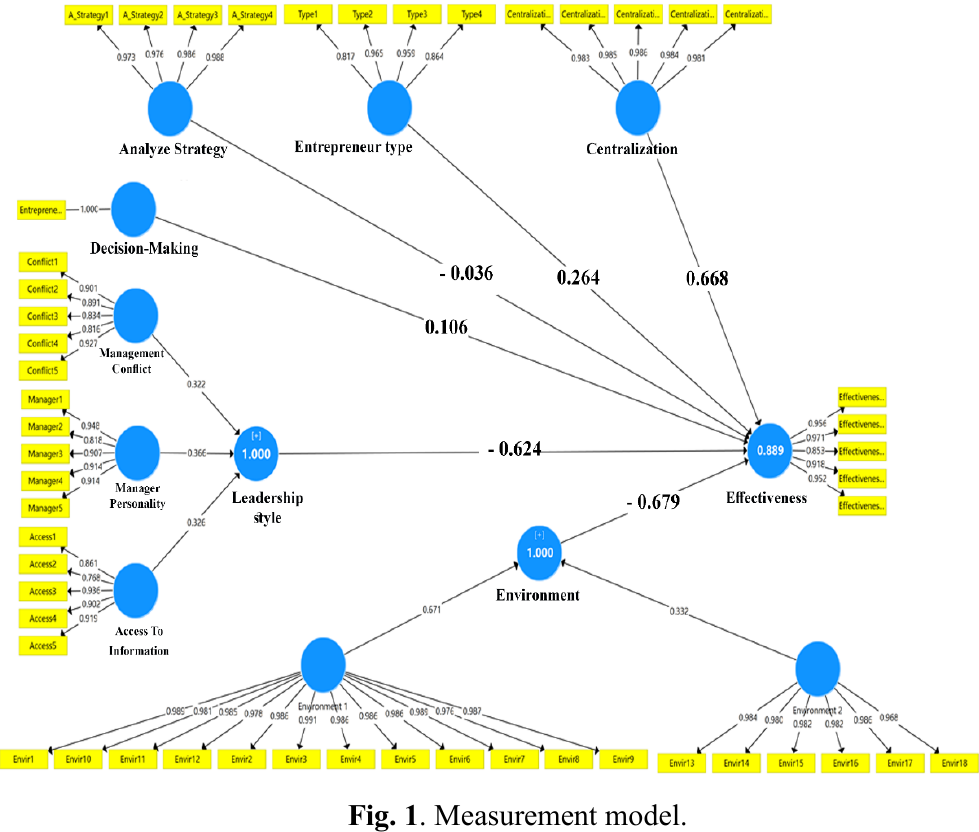
Fig. 1 . Measurement